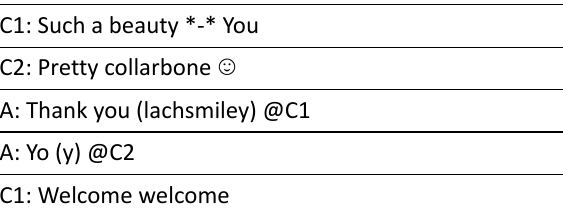
Table 1. English translation of German comments which are visible in Figure 2.